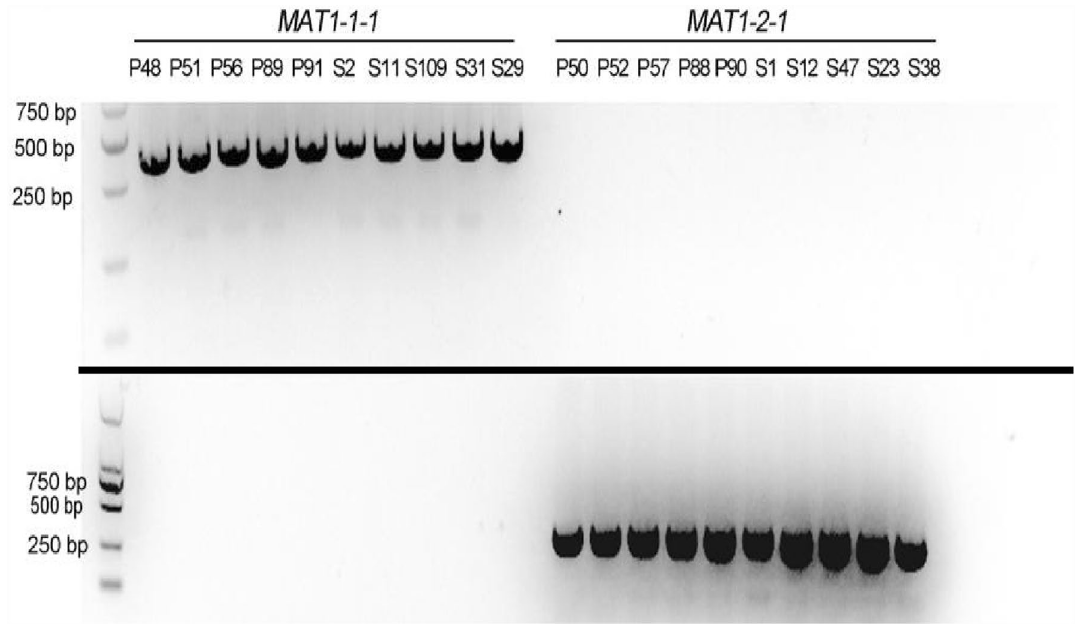
Figure 2. Reconfirmation of mating type of 20 randomly selected V. dahliae isolates using highly specific primers. M; Trans 2 K marker, left; shows all MAT1-1 isolates from both potato and sunflowers, right; shows all MAT1-2 isolates from both potato and